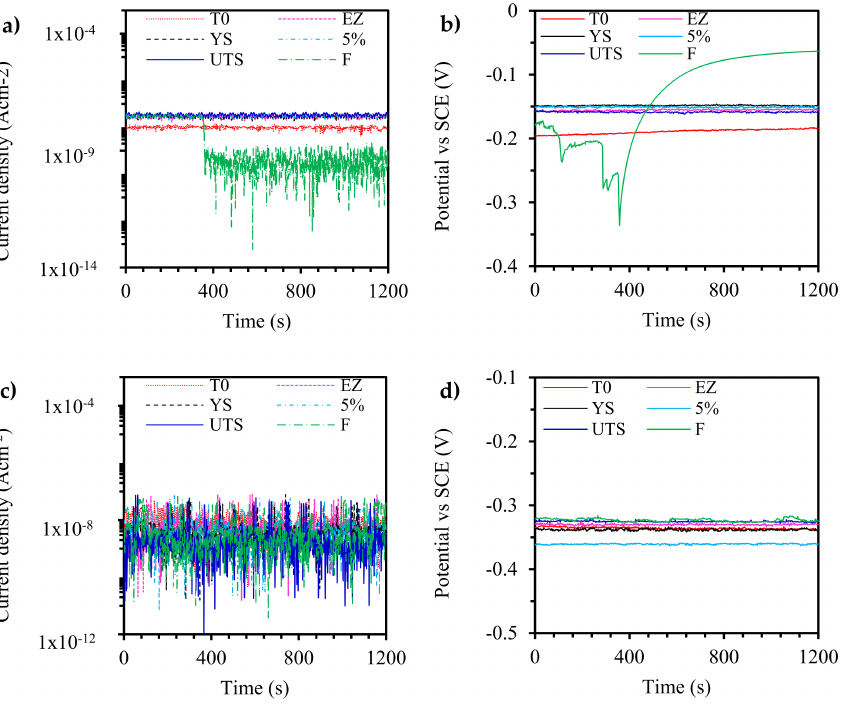
Figure 11. The current and potential time series from the EN measurements for the ERNiCrMo-3 weld in Na 2 S 2 O 3 ( a , b ) RT and ( c , d ) 80 ◦